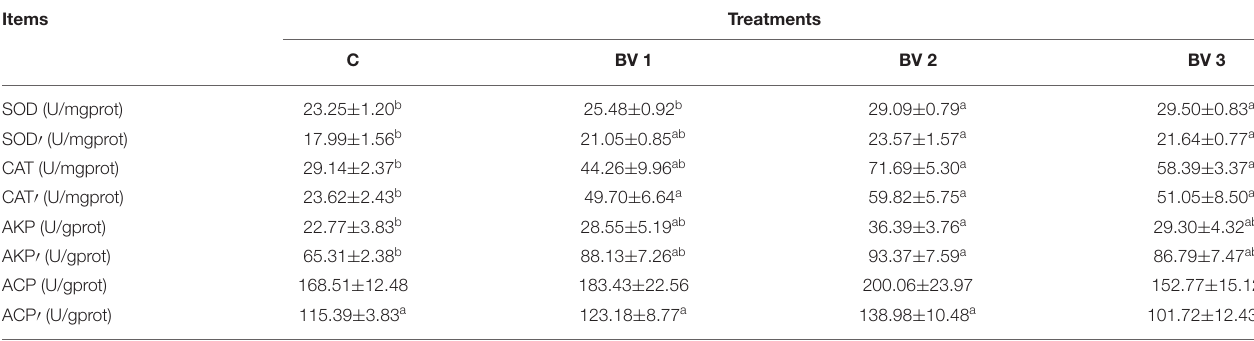
TABLE 4 | Immune-related enzyme activities in the hepatopancreas of L. vannamei fed diets containing 0 CFU/g (C), 10 5 CFU/g (BV1), 10 7 CFU/g (BV2), or 10 9 CFU/g (BV3) B. velezensis for 6 weeks and then, infected with 10 7 CFU/ml V. parahaemolyticus for one week (use words with a superscript comma).